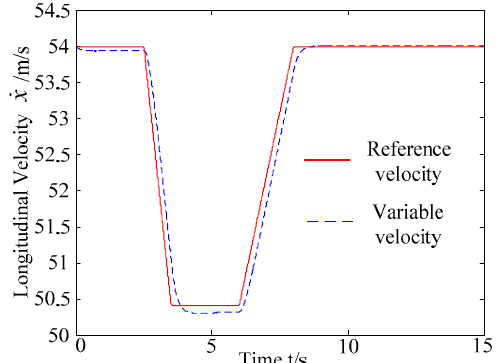
Figure 28. Longitudinal velocities of vehicle p under different velocities of vehicle q .